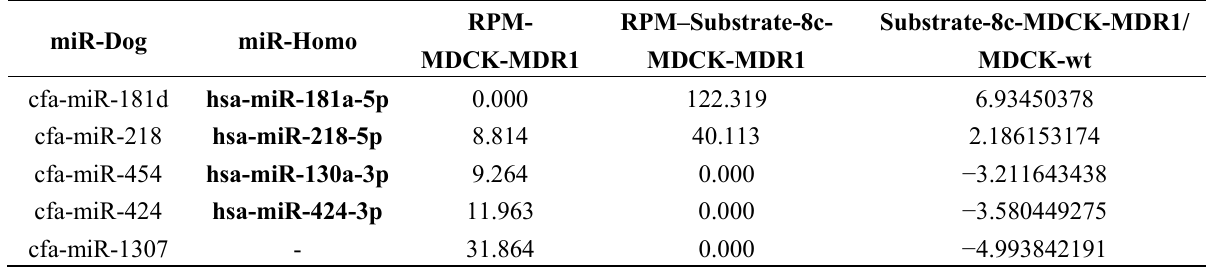
Table 3. Expression of five microRNAs known and selected by miRDeep2 in MDR, regulated by compound 8c